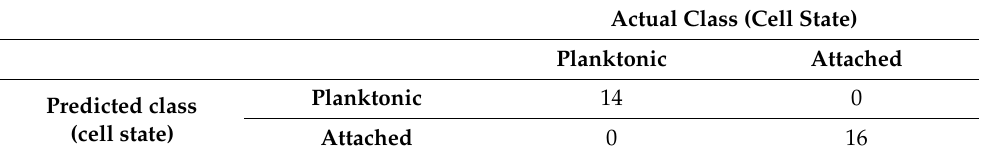
Table 1. Confusion matrix of the test samples for the trained SVM